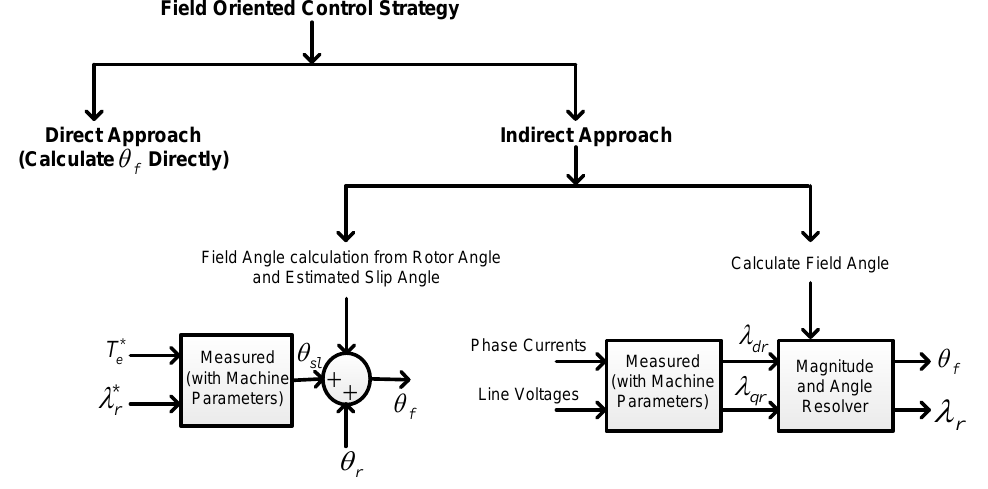
Figure 3. Classification of the Field Oriented Control Scheme [24,25].